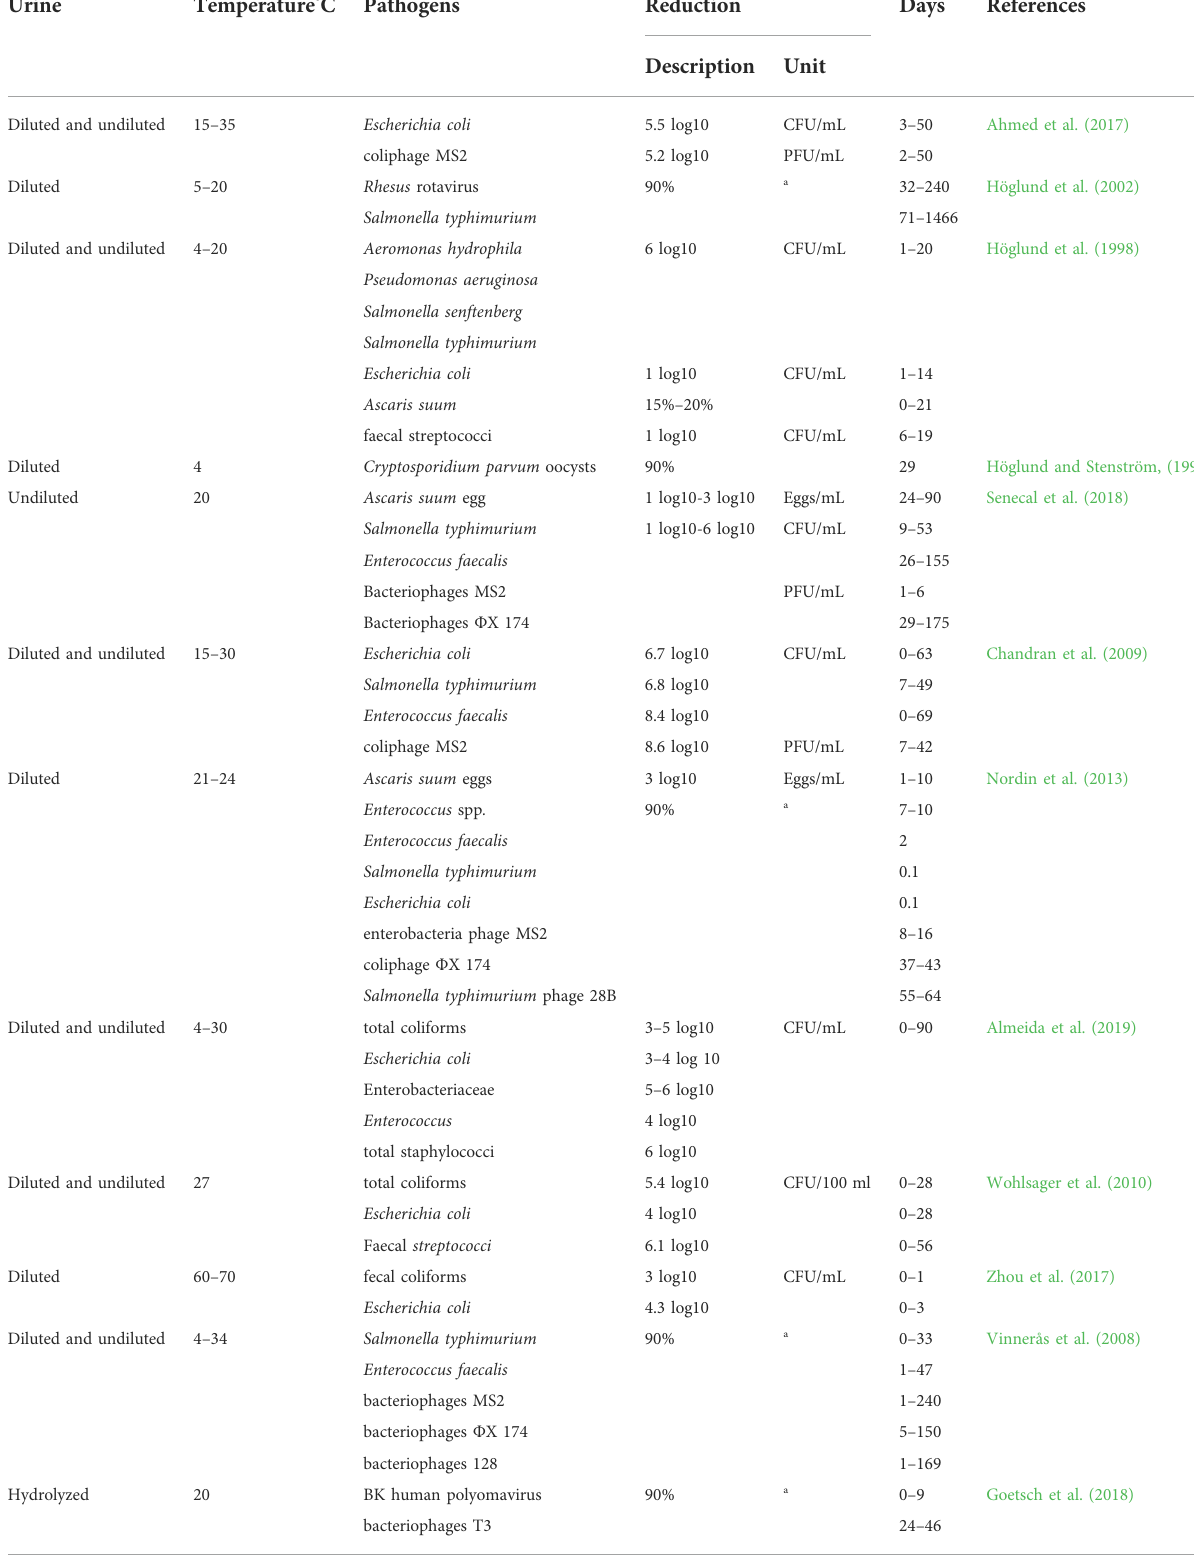
TABLE 1 A summary on the reduction of pathogens in storage of